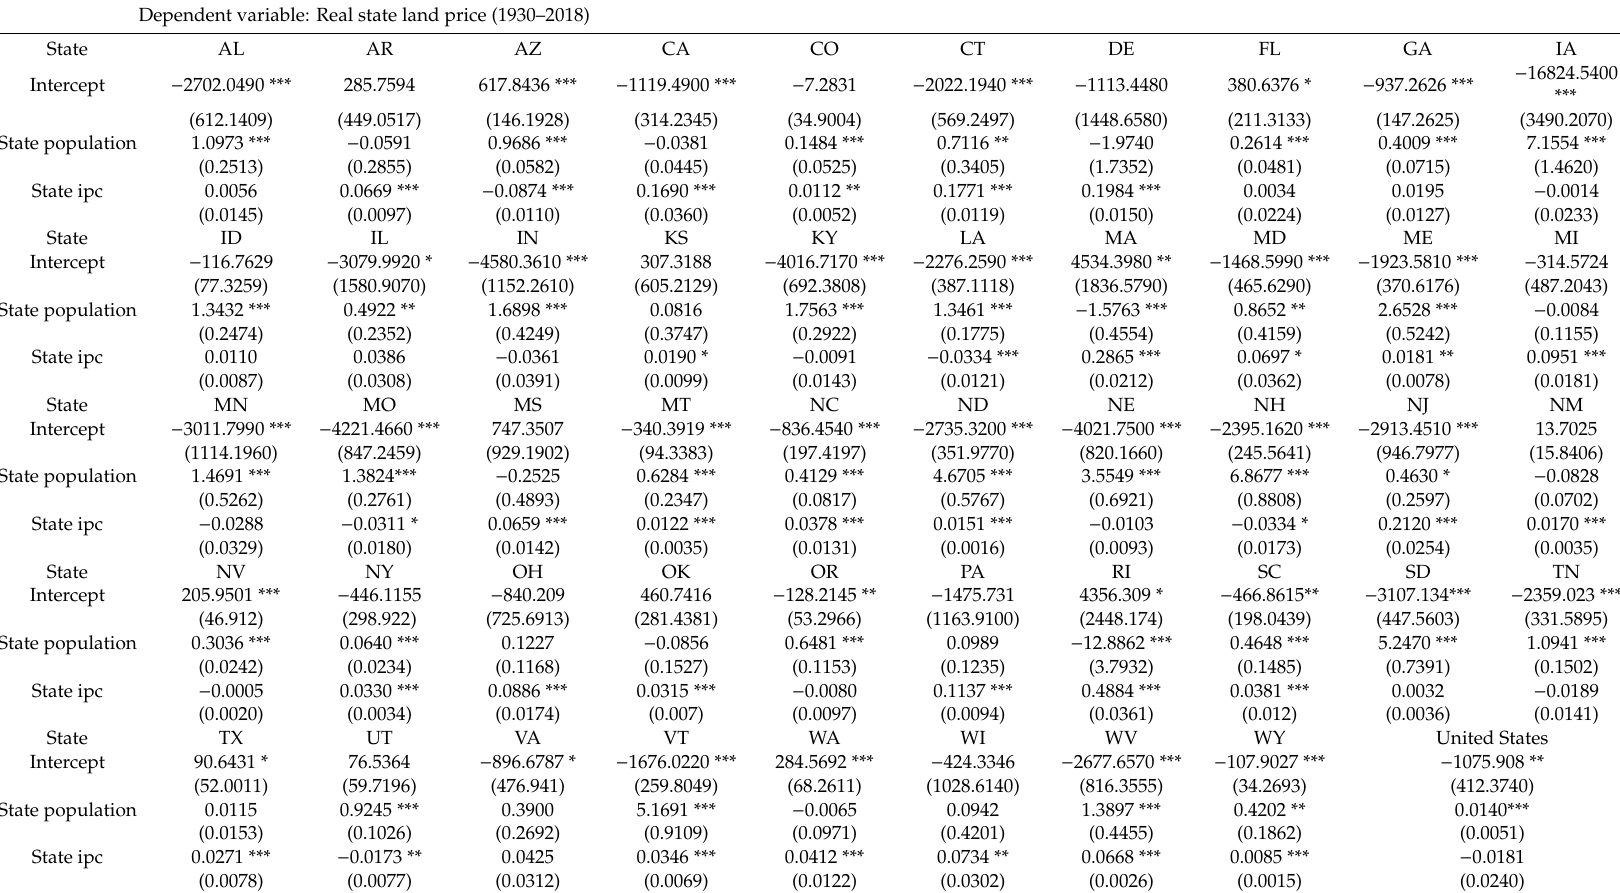
Table 2. The impact of state level population and income per capita on agriculture land price, real